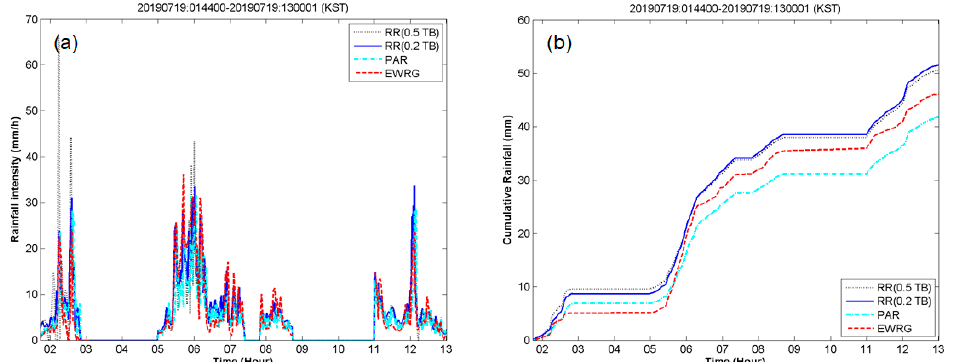
Figure 12. Comparison between rainfall obtained by the EWRG and rain gauges for event 2. ( a ) EWRG average rainfall (mm / h) and rain gauge rainfall (mm / h); ( b ) cumulative EWRG average rainfall (mm) and cumulative rain gauge rainfall (mm). The red dotted line represents the average rainfall of the EWRG prototype; the solid blue line and the black dotted line represent rainfall observed by the tipping bucket rain gauges (0.2, 0.5), and the light blue dashed line represents rainfall from the Parsivel disdrometer.